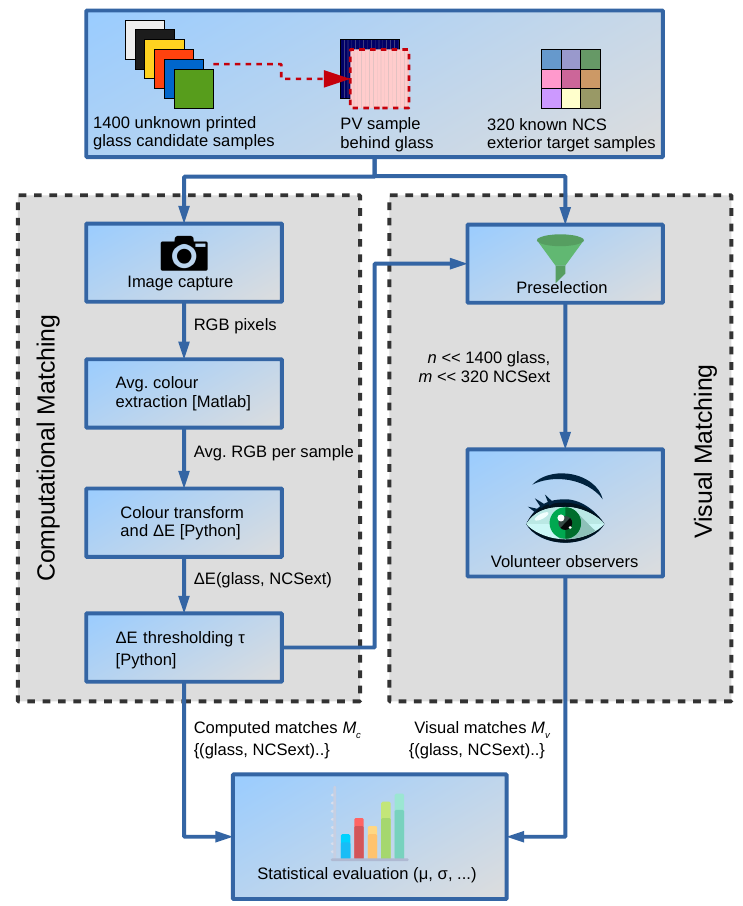
Figure 1. Overview of our coloured PV matching methodology. Using an image-based approach, we computationally match a subset of the 1400 unknown candidate colours on printed glass combined with PV to a subset of the 320 known target NCS exterior colours based on the pairwise ∆ E colour difference. We then verify the set of computed matches M c with a set of visual matches M v using volunteer observers, and evaluate them